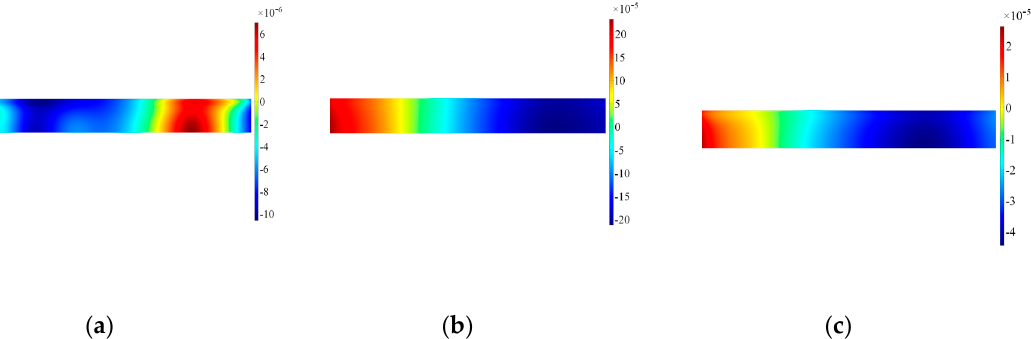
Figure 12. Surface plot for out-of-plane velocity on the alumina wear-plate, Configuration A. Note that data are plotted at timeframes of 100 μ s ( a ), 300 μ s ( b ) and 500 μ s ( c ).